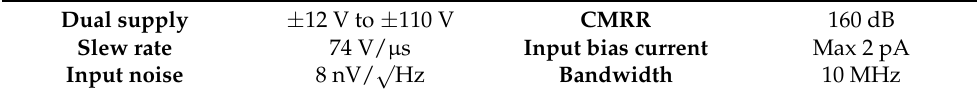
Table 1. Main features of the operational amplifier.